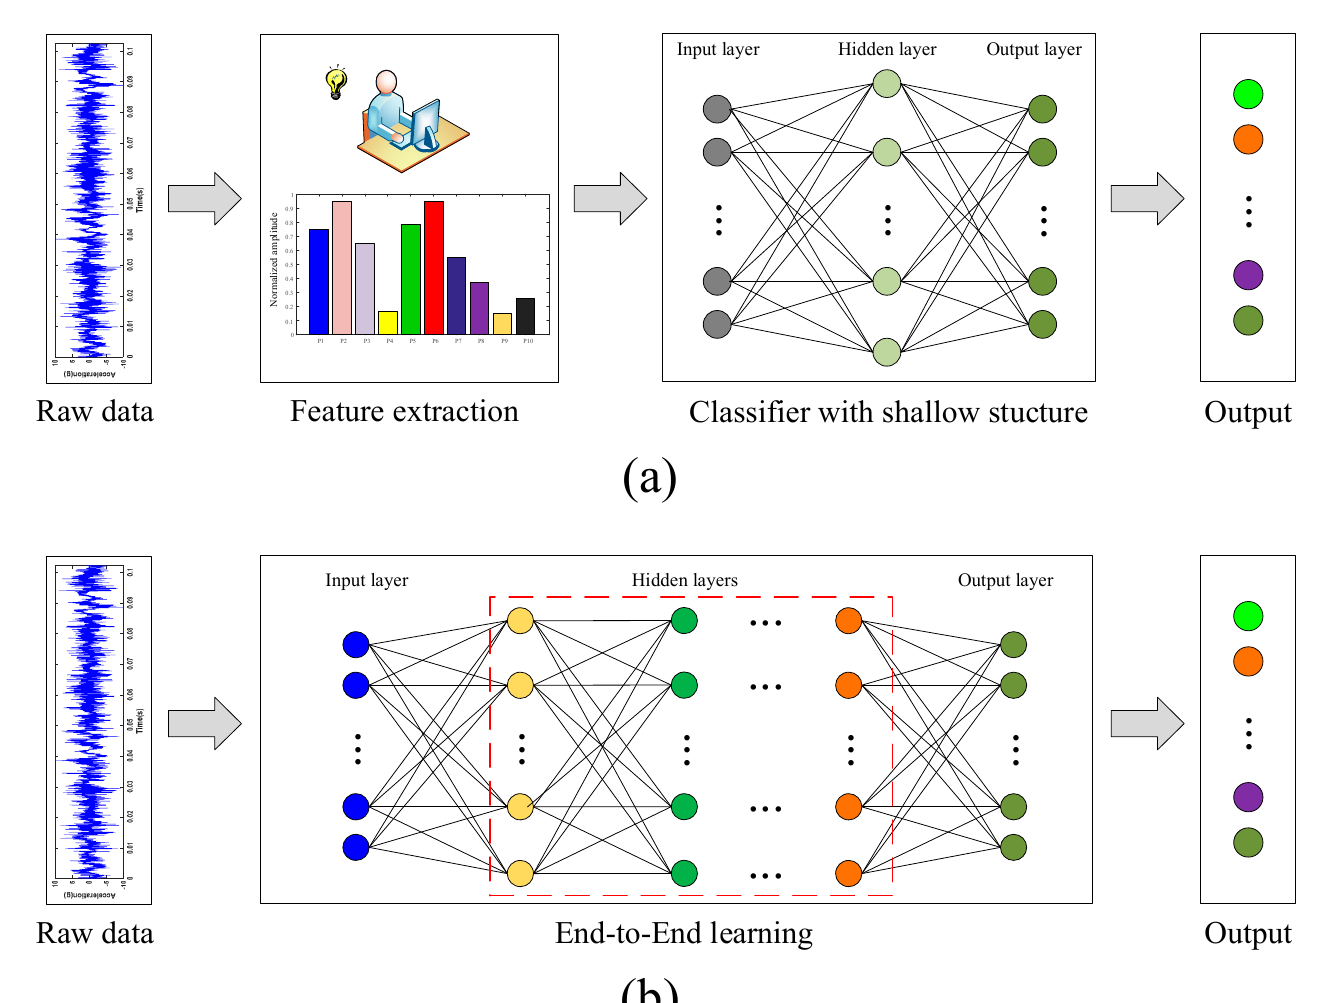
Figure 2. Comparison between two techniques: ( a ) traditional machine learning and ( b ) deep learning.